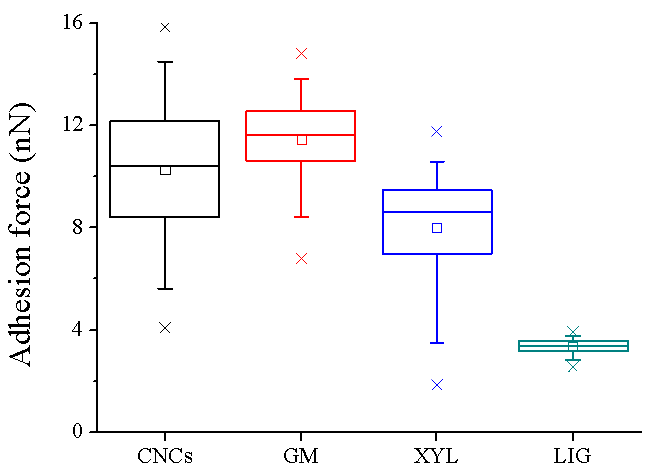
Figure 4. Box plot of the statistical analysis of the force distributions obtained between PBS functionalized tips and the different films.